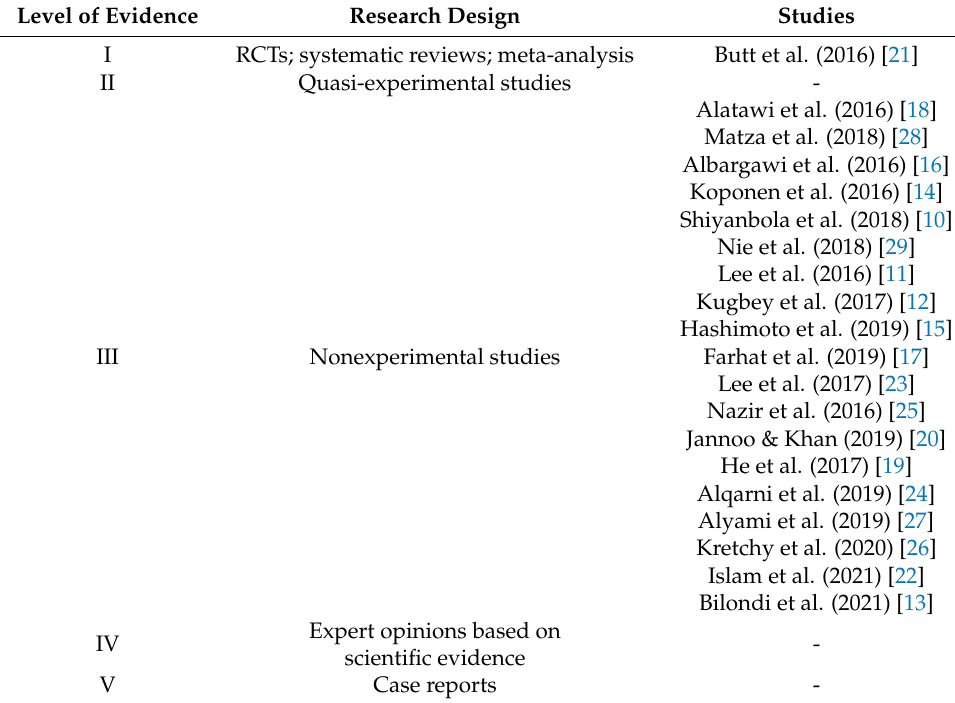
Table 3. Levels of Evidence for the 20